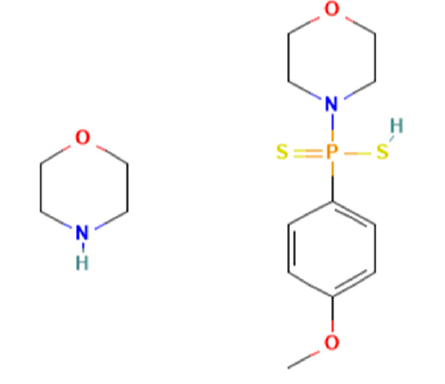
Figure 1. Chemical structure of GYY4137.